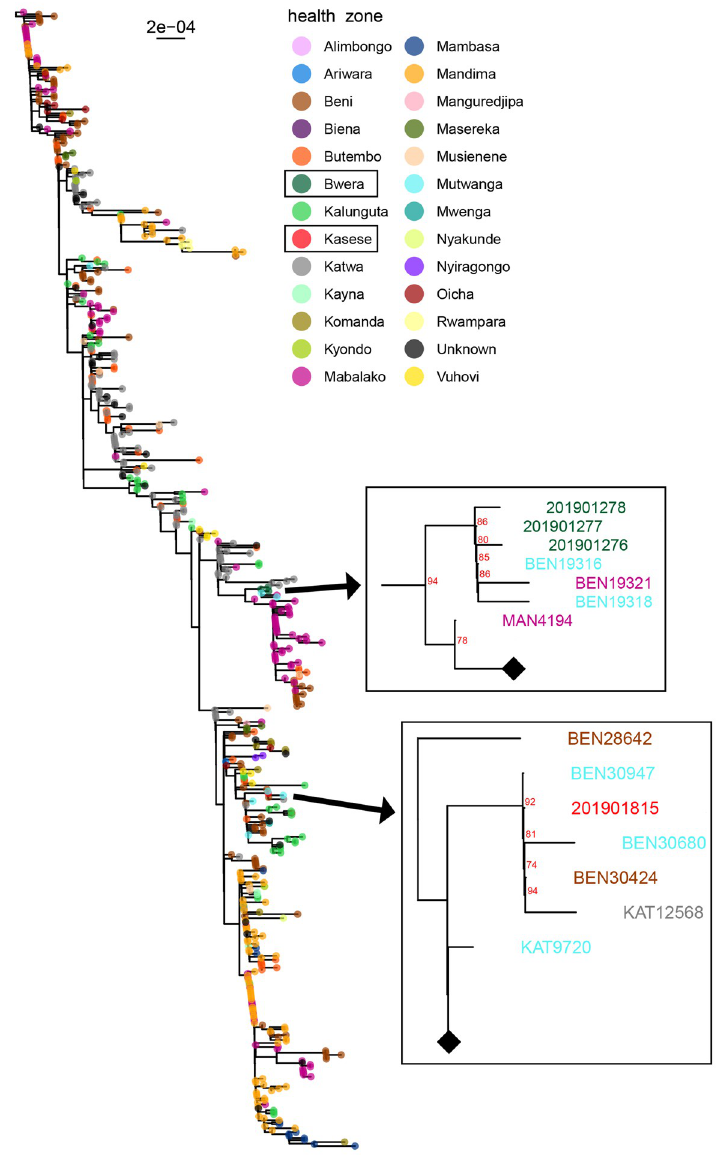
Fig 5. Phylogenetic tree showing relationship between the imported cases in Kasese district, Uganda with Source Transmission chains in DRC: Specimen number (Genbank accession number): 201901276